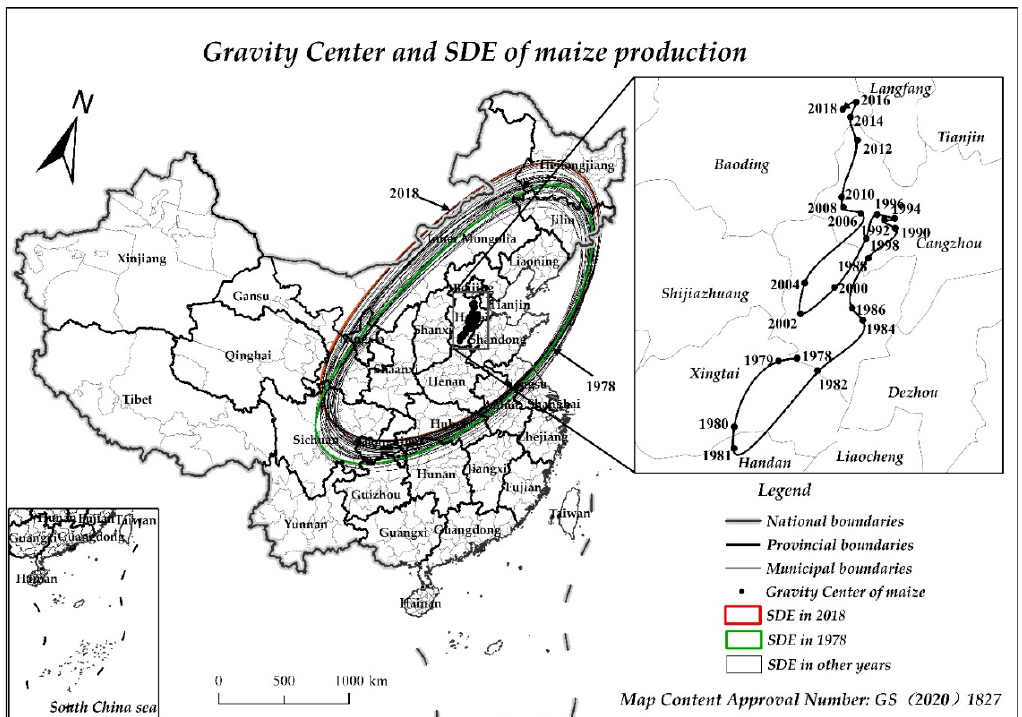
Figure 4. The GC and standard deviation elliptic of maize production in China since 1978.